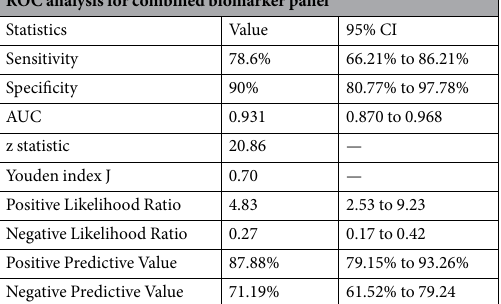
Table 3. Diagnostic efficacy parameters for panel of combined autoantibody biomarkers (PGAM1, CMYC, MUC1, TPI, and